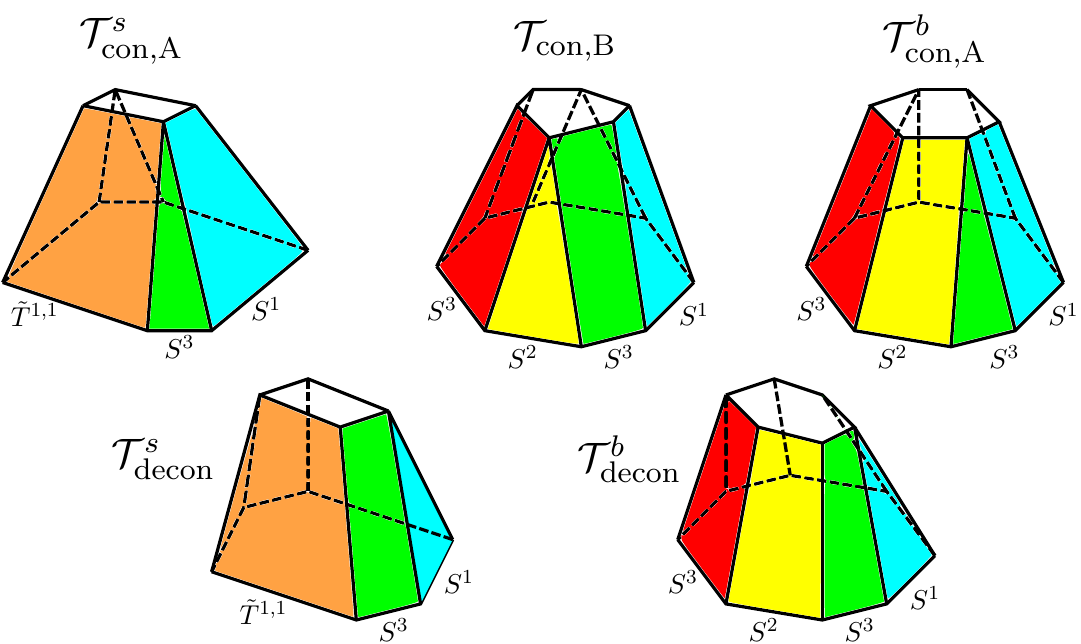
Figure 3 . Top row: confined thermal states of the cascading gauge theory, obtained from the compactification of the Euclidean time direction as in (1.1) of the corresponding vacua, see fig- ure 2. Bottom row, left panel: deconfined thermal states with the unbroken U(1) symmetry — the Klebanov-Tseytlin black holes. Bottom row, right panel: deconfined thermal states with the U(1) symmetry spontaneously broken to Z 2 — the Klebanov-Strassler black